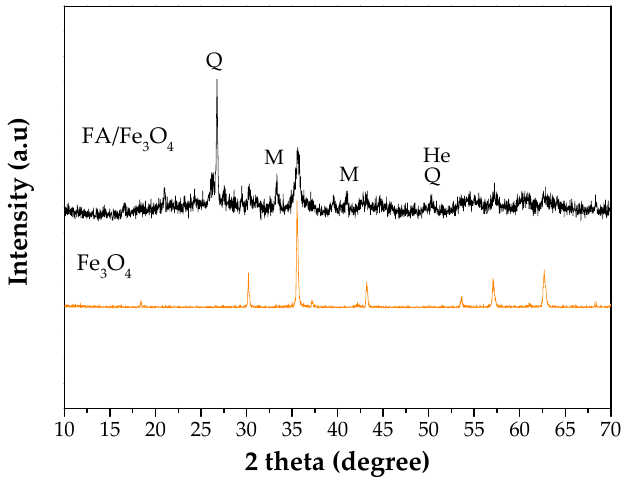
Figure 4. X-ray diffraction patterns of Fe 3 O 4 and FA/Fe 3 O 4.